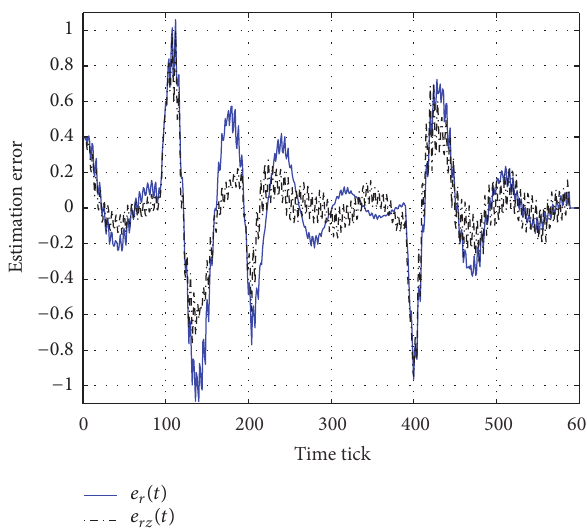
Figure 3: Estimation errors for the proposed method and round robin with RTZ.